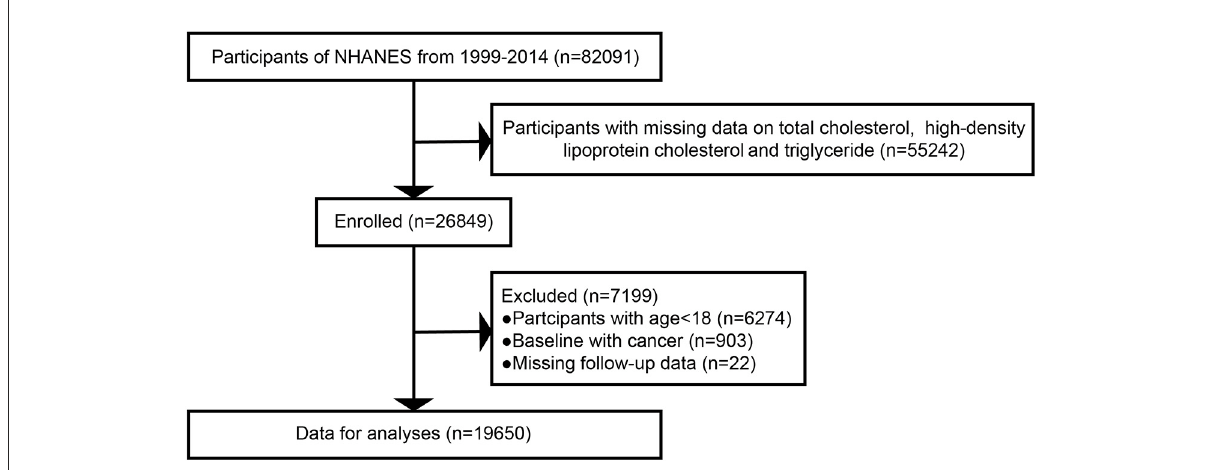
FIGURE1 Study flow chart. NHANES, National Health and Nutrition Examination Survey.